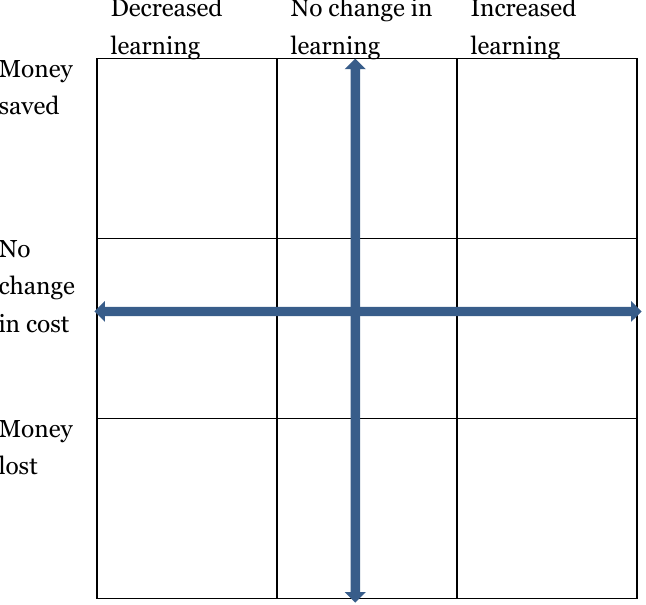
Figure 1. Possible outcomes in cost and education when using